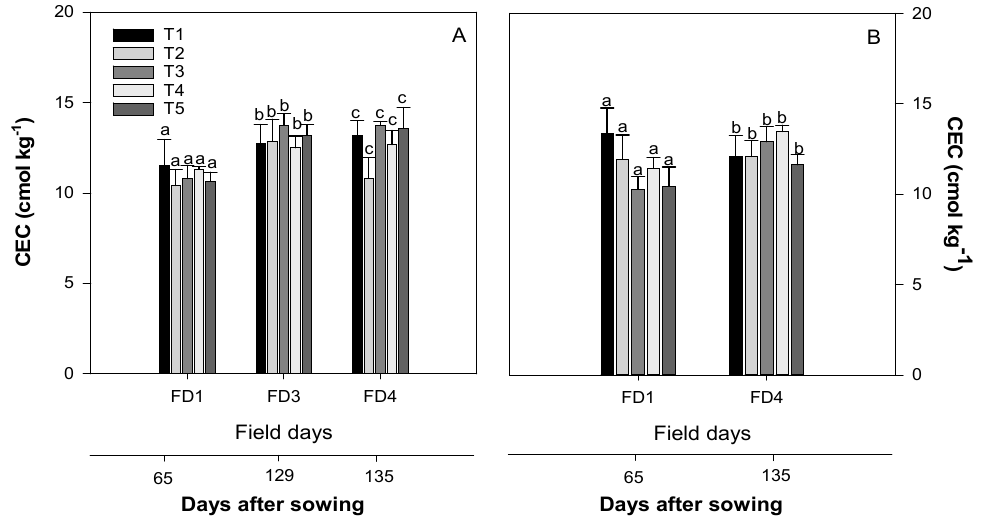
Figure 6. Effect of different soil amendments on temporal variations in cation exchange capacity at 0–10 cm ( A ) and 10–20 cm ( B ) sowing depth in podzolic soils under various nutrient management practices. Each vertical bar represents mean whereas bar errors show ± standard error for three replications. Lettering is independent of each